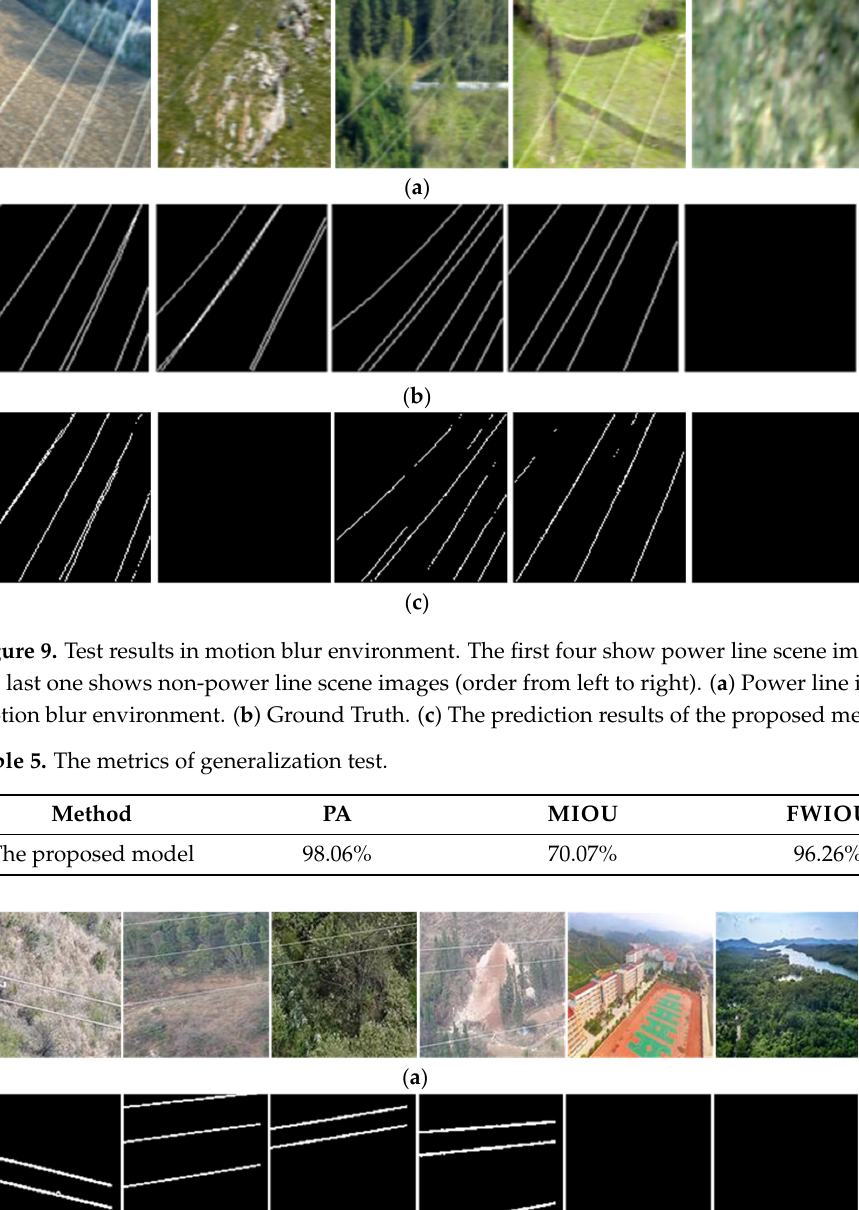
Table 5. The metrics of generalization test.